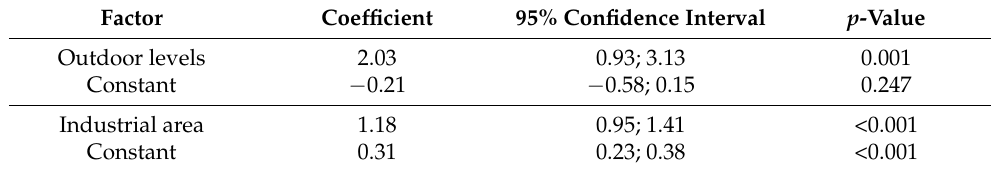
Table 3. Building factors and outdoor sources relevant for benzene levels. Coefficients in µ g/m 3